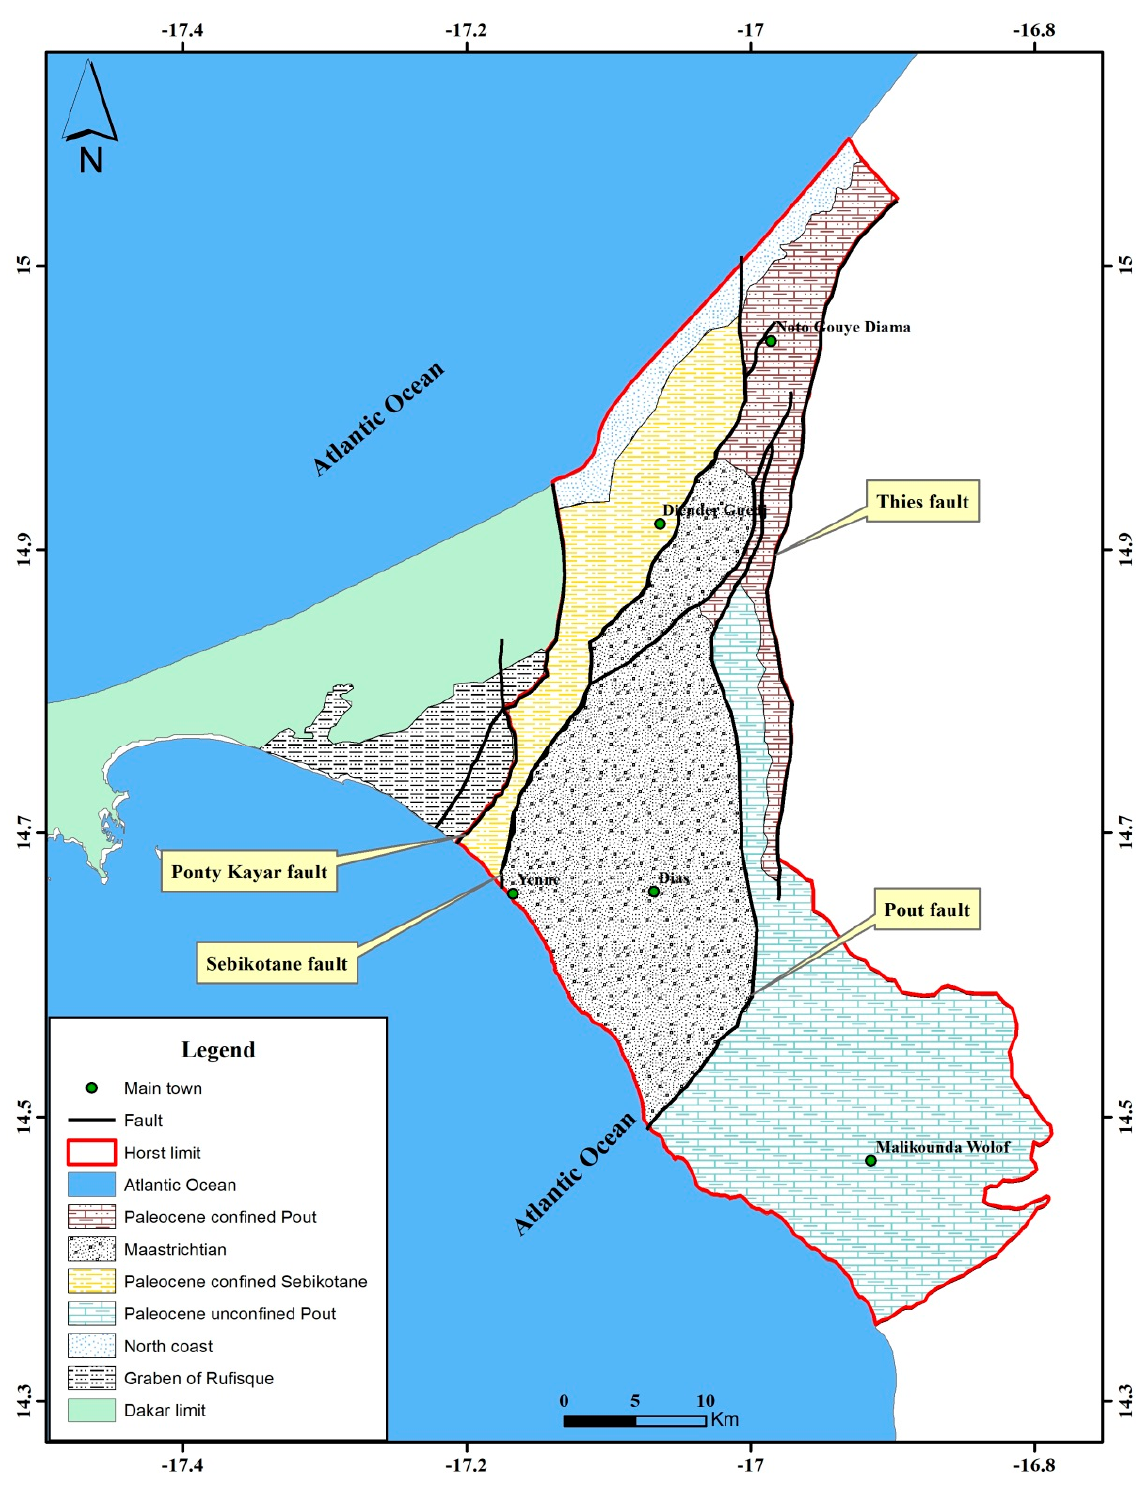
Figure 2. Aquifer formations in the Peninsula of Dakar (modified from [39]).